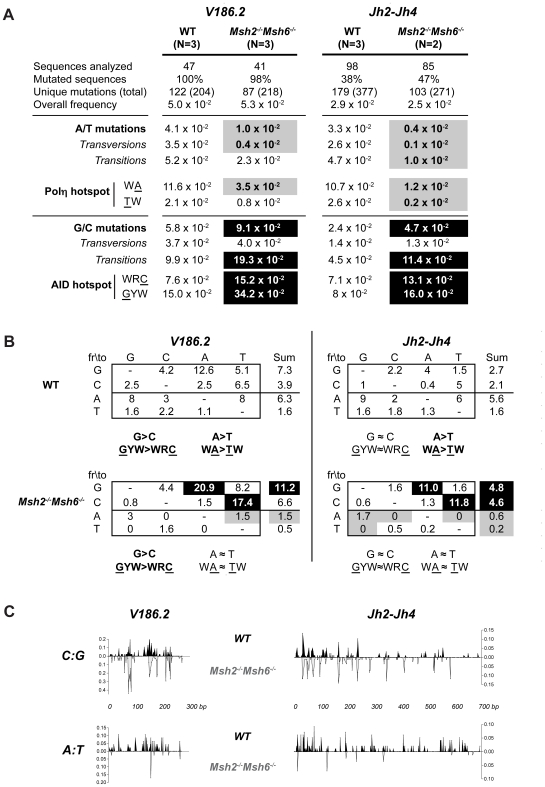
Effects of MSH2/MSH6 deficiency on somatic hypermutation of V186.2 and Jh2-Jh4 regions.(A) Global analysis of unique mutation frequencies corrected for base composition. All mutation frequencies were calculated according to the standardization method suggested in SHMTool [30]. N denotes the number of animals assayed in each group. Counts of unique mutations and relative frequencies of mutations are shown in Figure S3. Black boxes denote statistically significant increase (p<0.05) of mutation frequency compared to WT; gray boxes denote significant decrease (p<0.05). For V186.2 region, the RT + PCR error rate was estimated to be 0.14×10−2 mutations/base because one G-to-A mutation was detected in the Cγ1 segment (39 bp) adjacent to the V186.2 region. (B) The spectrum of base substitutions presented as frequencies of mutation (x10−2 mutations/base) and corrected for base composition. The site in hotspot motifs that was scored for mutation is underlined. W  =  A/T, R  =  A/G and Y  =  C/T. (C) Distribution of mutations in the V186.2 (273 bp) and Jh2-Jh4 (693 bp) regions. The x-axis indicates the mutation positioning and the y-axis indicates the frequency of sequences mutated at each site. Mutation data from wildtype or Msh2−/−Msh6−/− mice is presented above or below the x-axis, respectively.